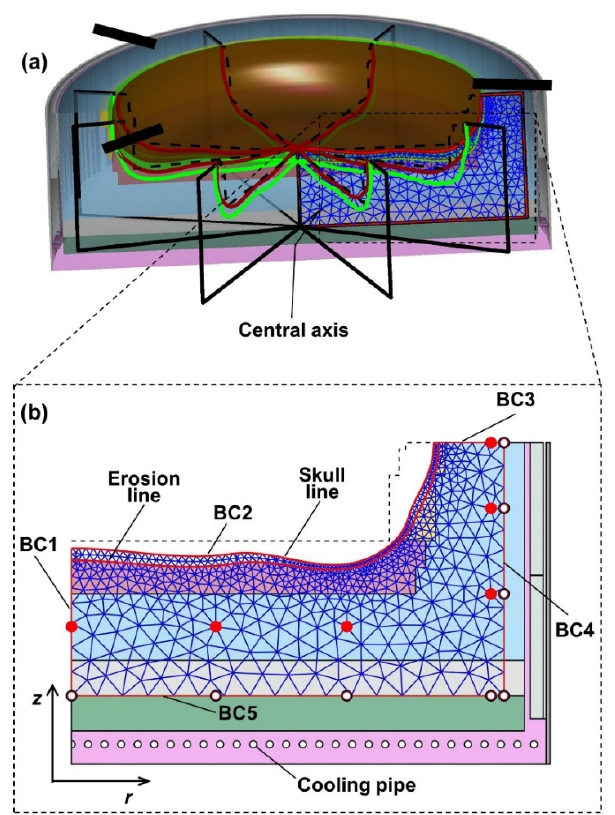
Figure 2. Schematic illustration of the key treatments in the present wear model: ( a ) aggregation of two-dimensional results into a three-dimensional representation (with the tapholes denoted by black bars), ( b ) computational mesh and boundary conditions of a certain vertical section.